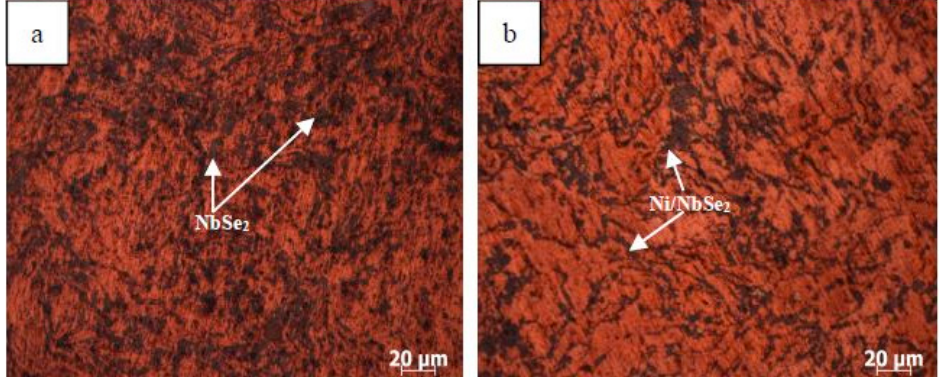
Figure 2. Microstructure of Cu/Ni/NbSe 2 composites, CN15 ( a ) and CNE15 ( b ).